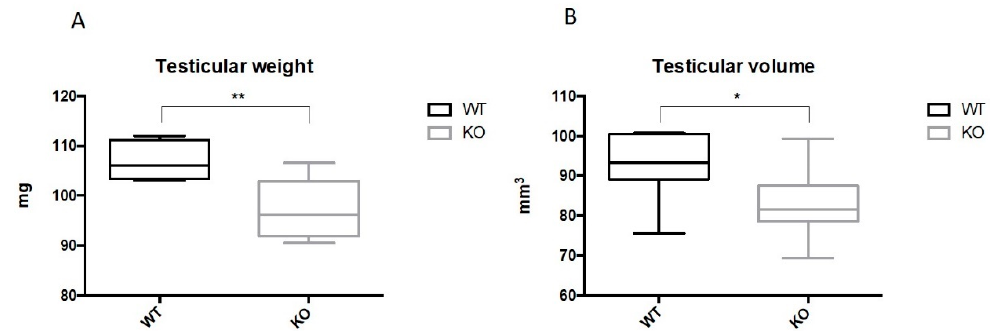
Figure 2. Kcnj16 (Kir5.1) ablation reduces testicular weight and volume. The box plots report the evaluation of weight ( A ) and volume ( B ) of testis collected from WT and KO mice ( n = 8; * p < 0.05; ** p < 0.01).